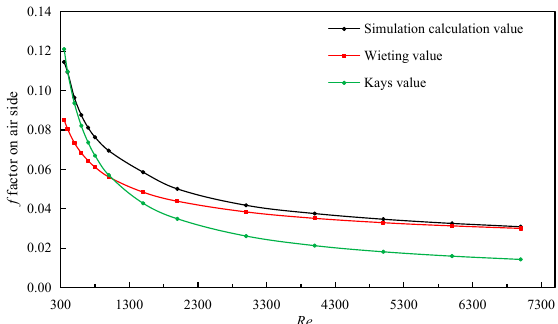
Figure 5. Comparison of f factors on air side.